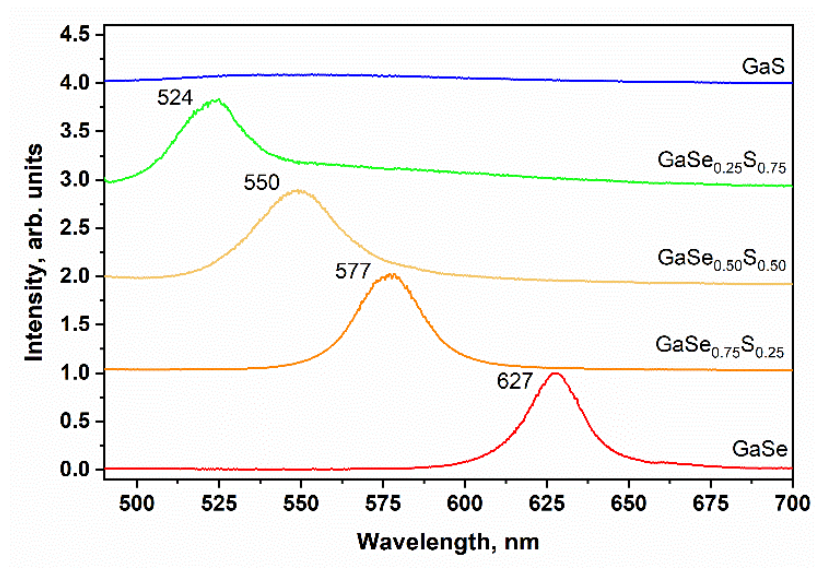
Figure 10. Photoluminescence spectra of the LPE GaSe 1 − x S x films recorded at room temperature.